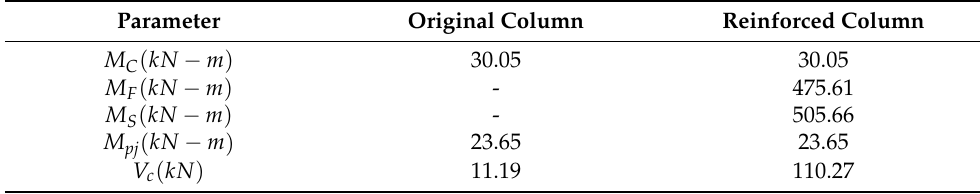
Table 2. Resistance of the column.